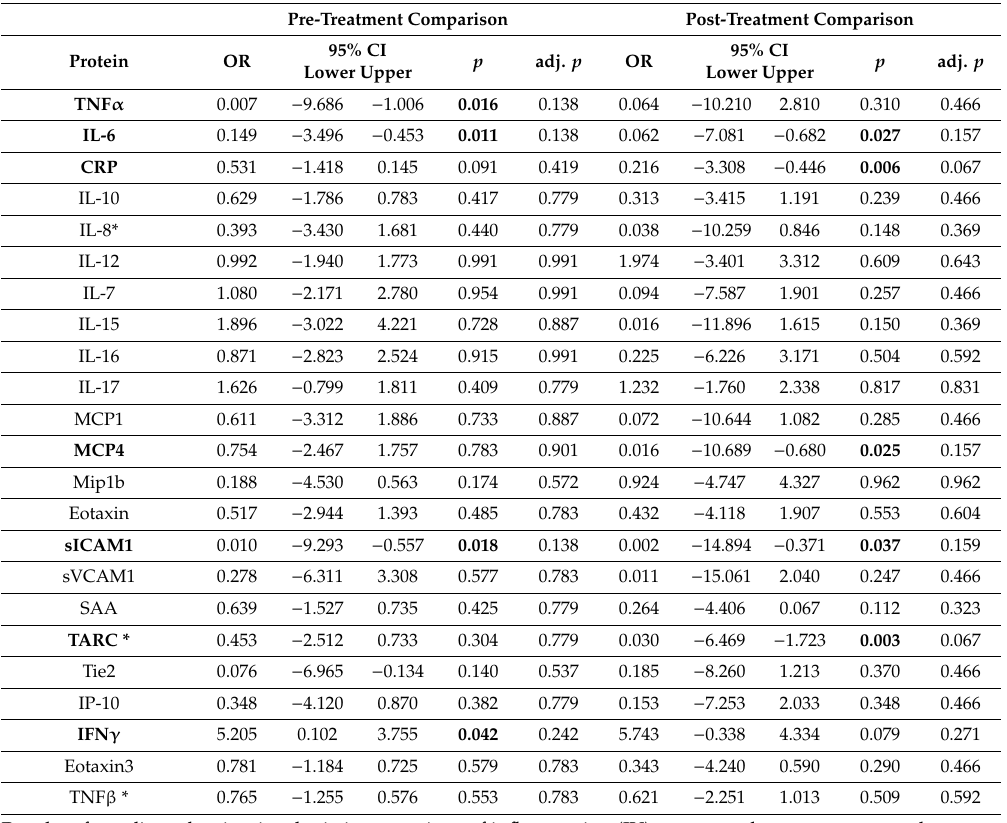
Table 2. Inflammatory associations with psychological therapy